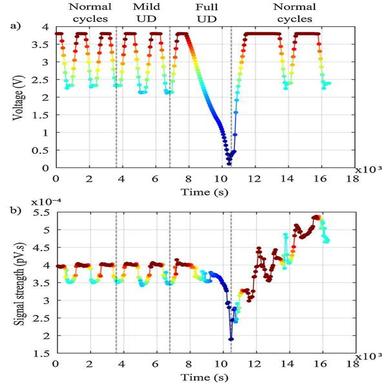
Acoustic signal in UD a) Voltage vs time plot; b) Signal strength vs time plot.